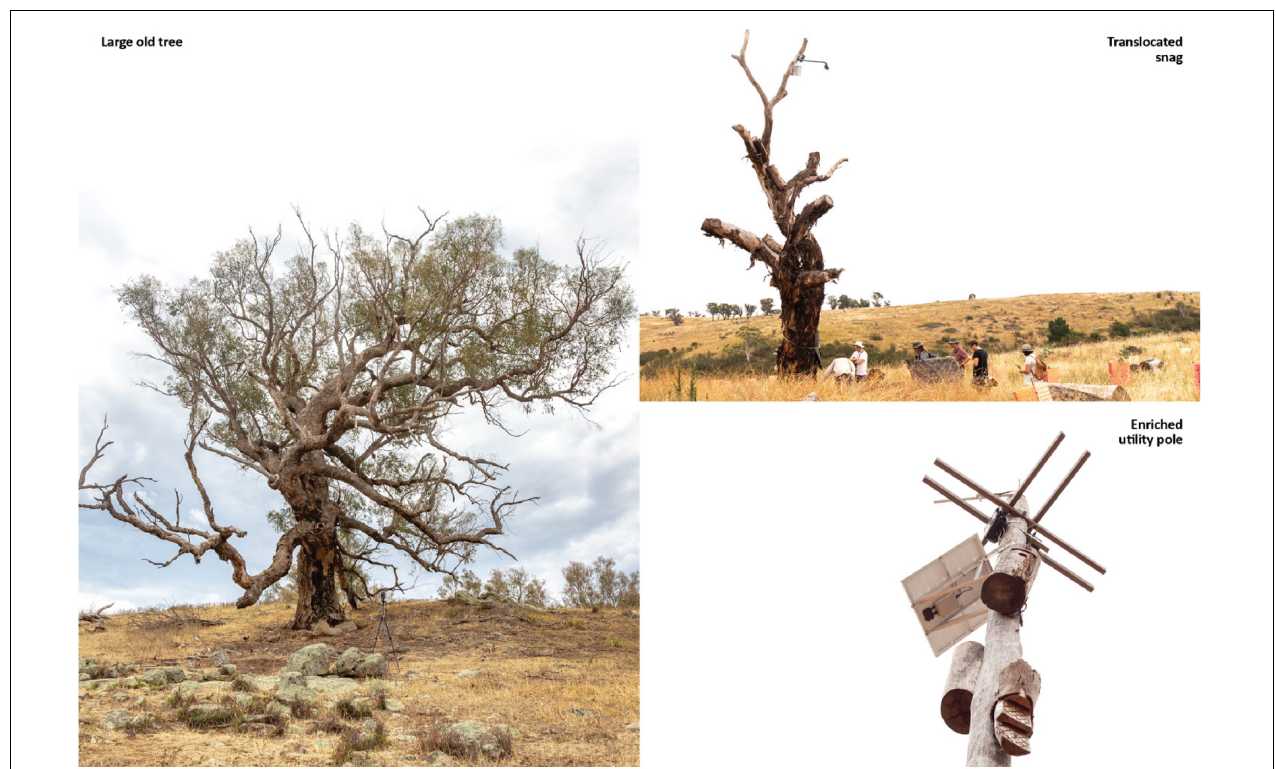
FIGURE 1 | Natural and artificial habitat structures of differing complexity: an old tree; a translocated dead tree (complex artificial habitat structure); an enriched utility pole (simple artificial habitat structure).